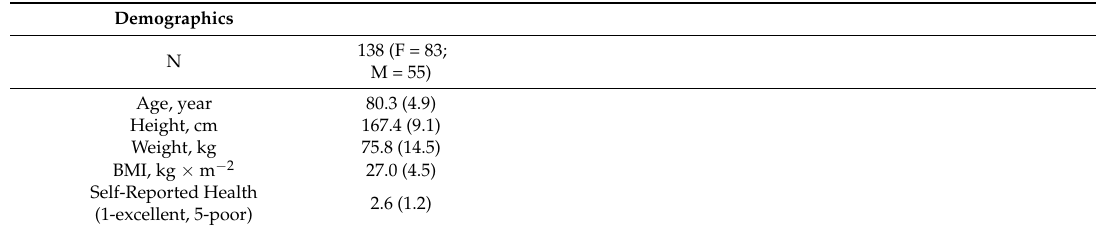
Table 1. Demographic, environmental and activity parameters (mean and standard deviation (SD)) for participants with complete data during summer and